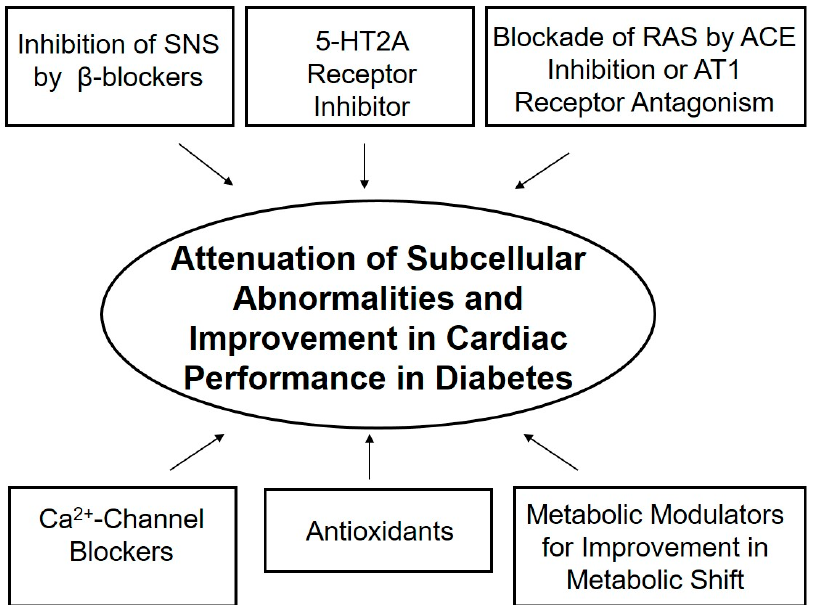
Figure 3. Interventions that may attenuate subcellular remodeling and improve cardiac performance in chronic diabetes.